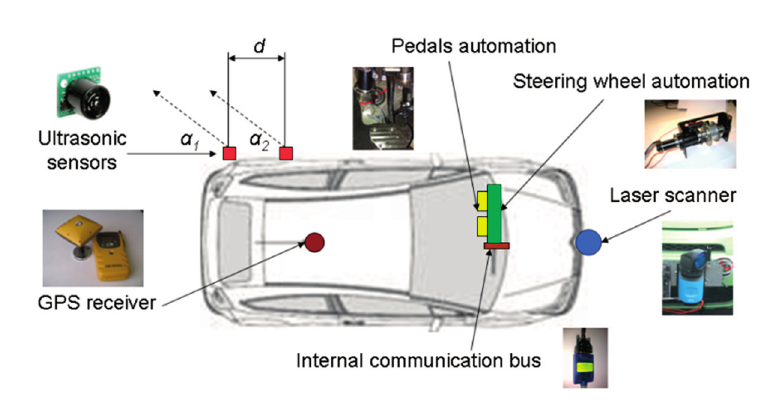
Figure 1. Environment detection sensors embedded in the